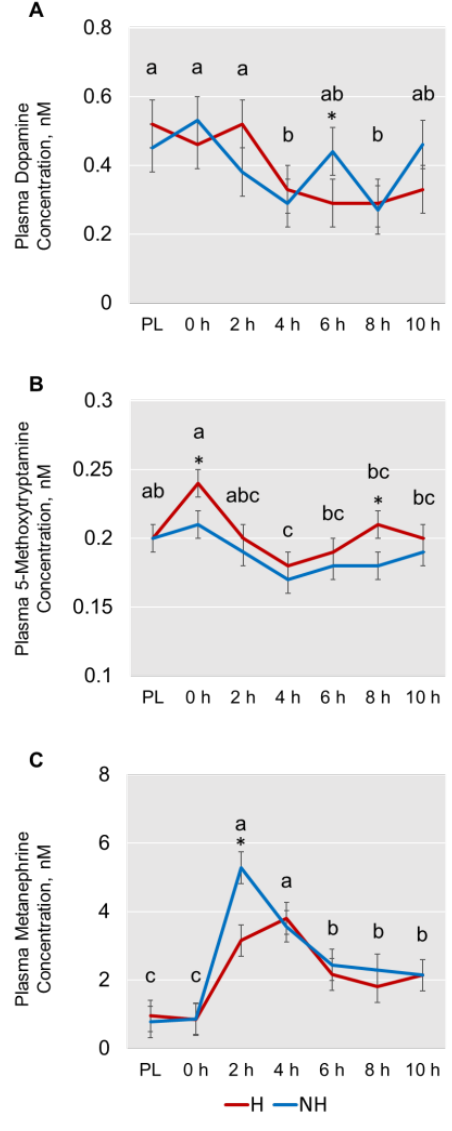
Figure 6. Plots of means ( ± SEM) showing changes in catecholamine (( A ) dopamine; ( B ) 5-methoxytryptamine; ( C ) metanephrine) concentrations over time (PL = Preload; Time main effect, p < 0.05). a–c Time main effect means (average of the two means at each time point) with different letters differ significantly by LSD test at p < 0.05. * TRT means at the time points indicated were significantly different by LSD test at p < 0.05.